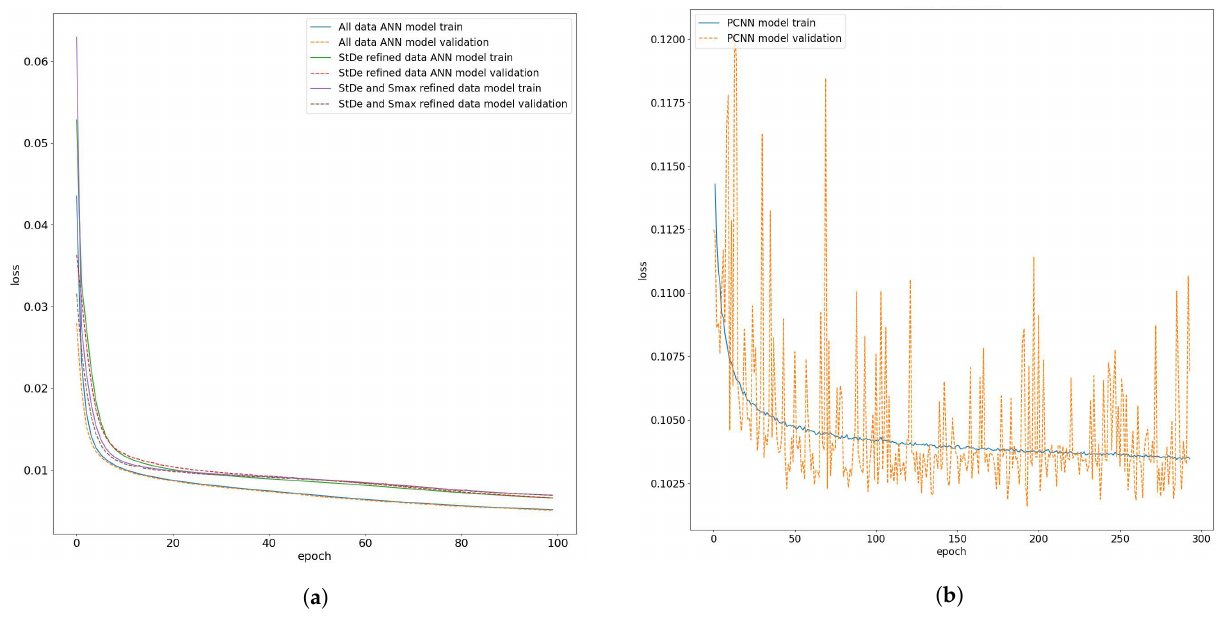
Figure 2. Comparing the training and test loss of the three ANNs and PCNN during training. ( a ) The training loss of the three ANNs seems to be similar, which the normal ANN having a lower loss. ( b ) The PCNN model has a higher loss compared to the other ANN model due the added regularization of the boundary condition loss. In both plots, the training loss is represented as solid lines while, the dotted lines illustrate the test loss at each